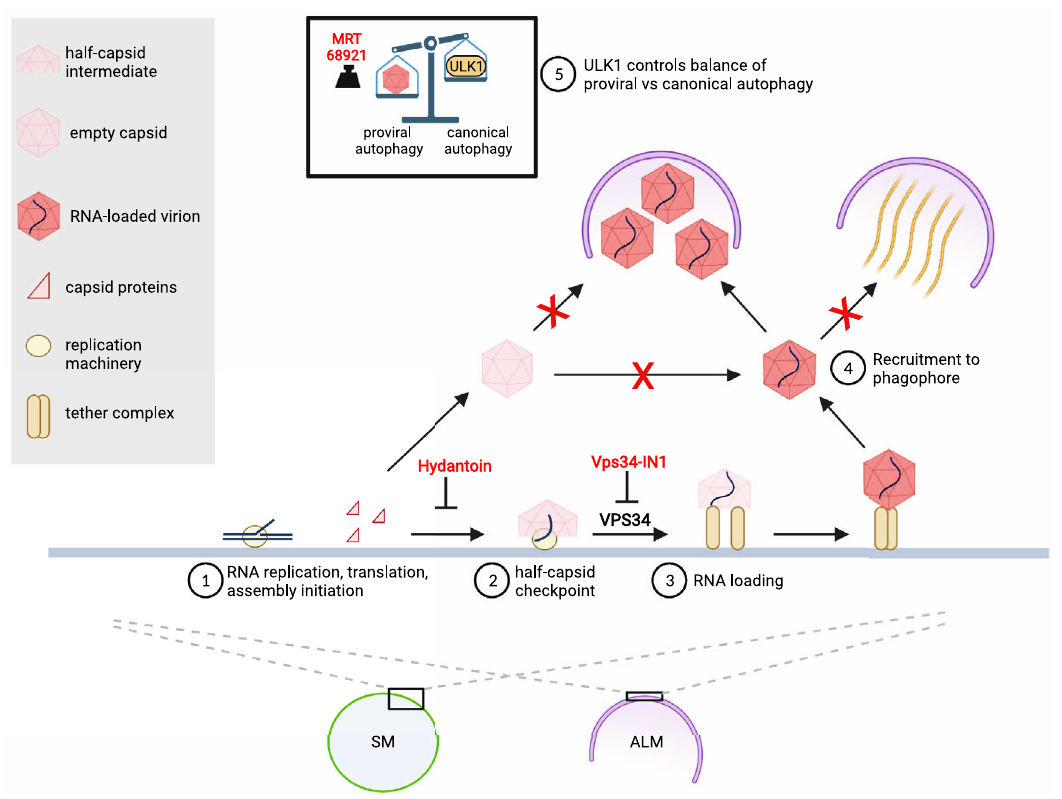
Fig. 6 | The interplay between autophagy and enterovirus replication is dynamic, selective, and sequential. This model illustrates how remodeled cyto- plasmicmembranesact asaplatformfor viral RNAreplication and asaproduction line for virion assembly. (1) Capsid proteins, produced as part of the membrane- associatedviralpolyprotein,assembleonthereplicationmembranetothepointof half-capsid intermediate. The antiviral drug Hydantoin leads to premature capsid release frommembranes.Awayfromthe replicationmembrane, capsids cannotbe loaded with RNA. (2) The assembly pauses at the long-lived half-capsid inter- mediatethatcarriesoutthe “ lateproofreading ” resultinginexclusiveincorporation of newly synthesized membrane-associated viral RNA 30 . The inhibition of